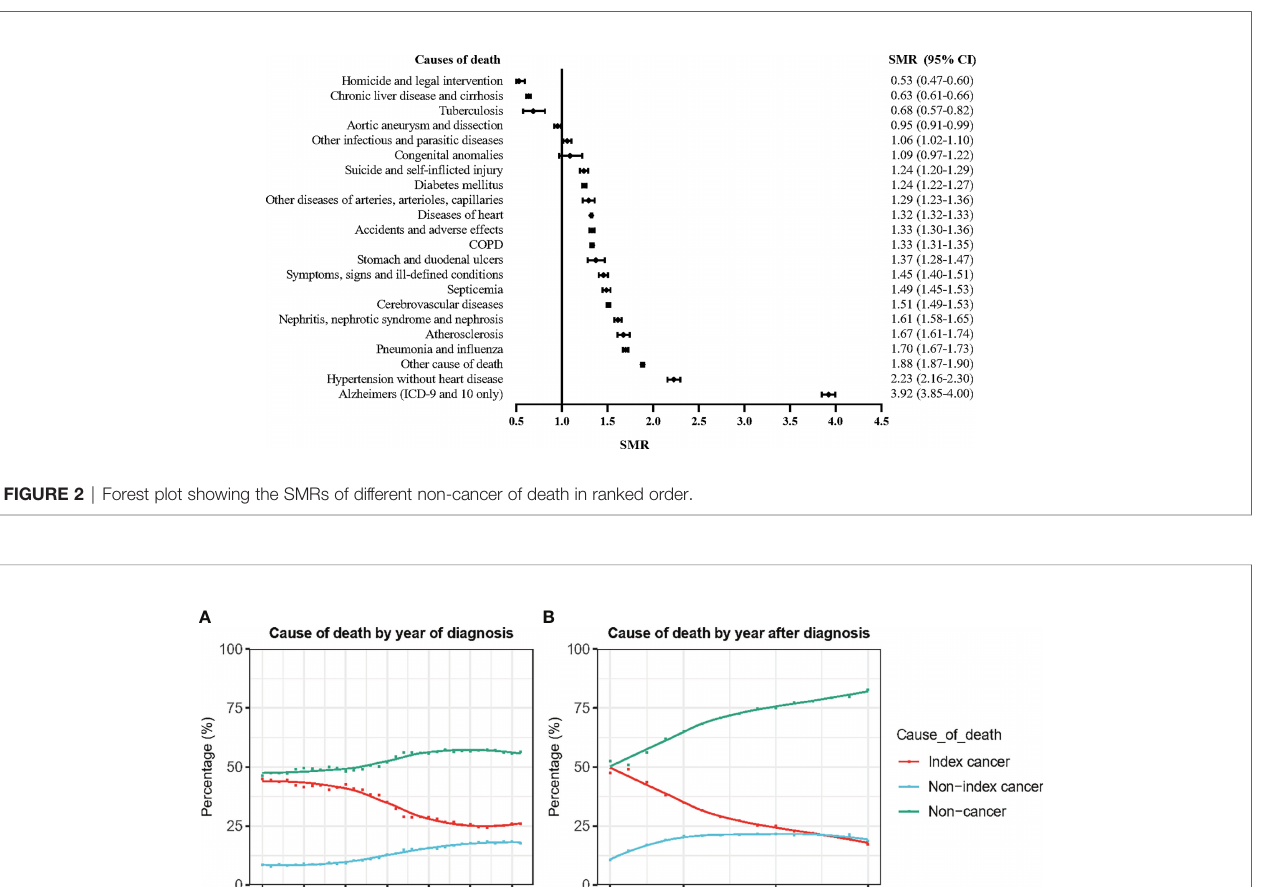
FIGURE 3 | Cause of death by year of death and time after diagnosis. (A) Cause of death by year of death. (B) Cause of death by time after diagnosis.